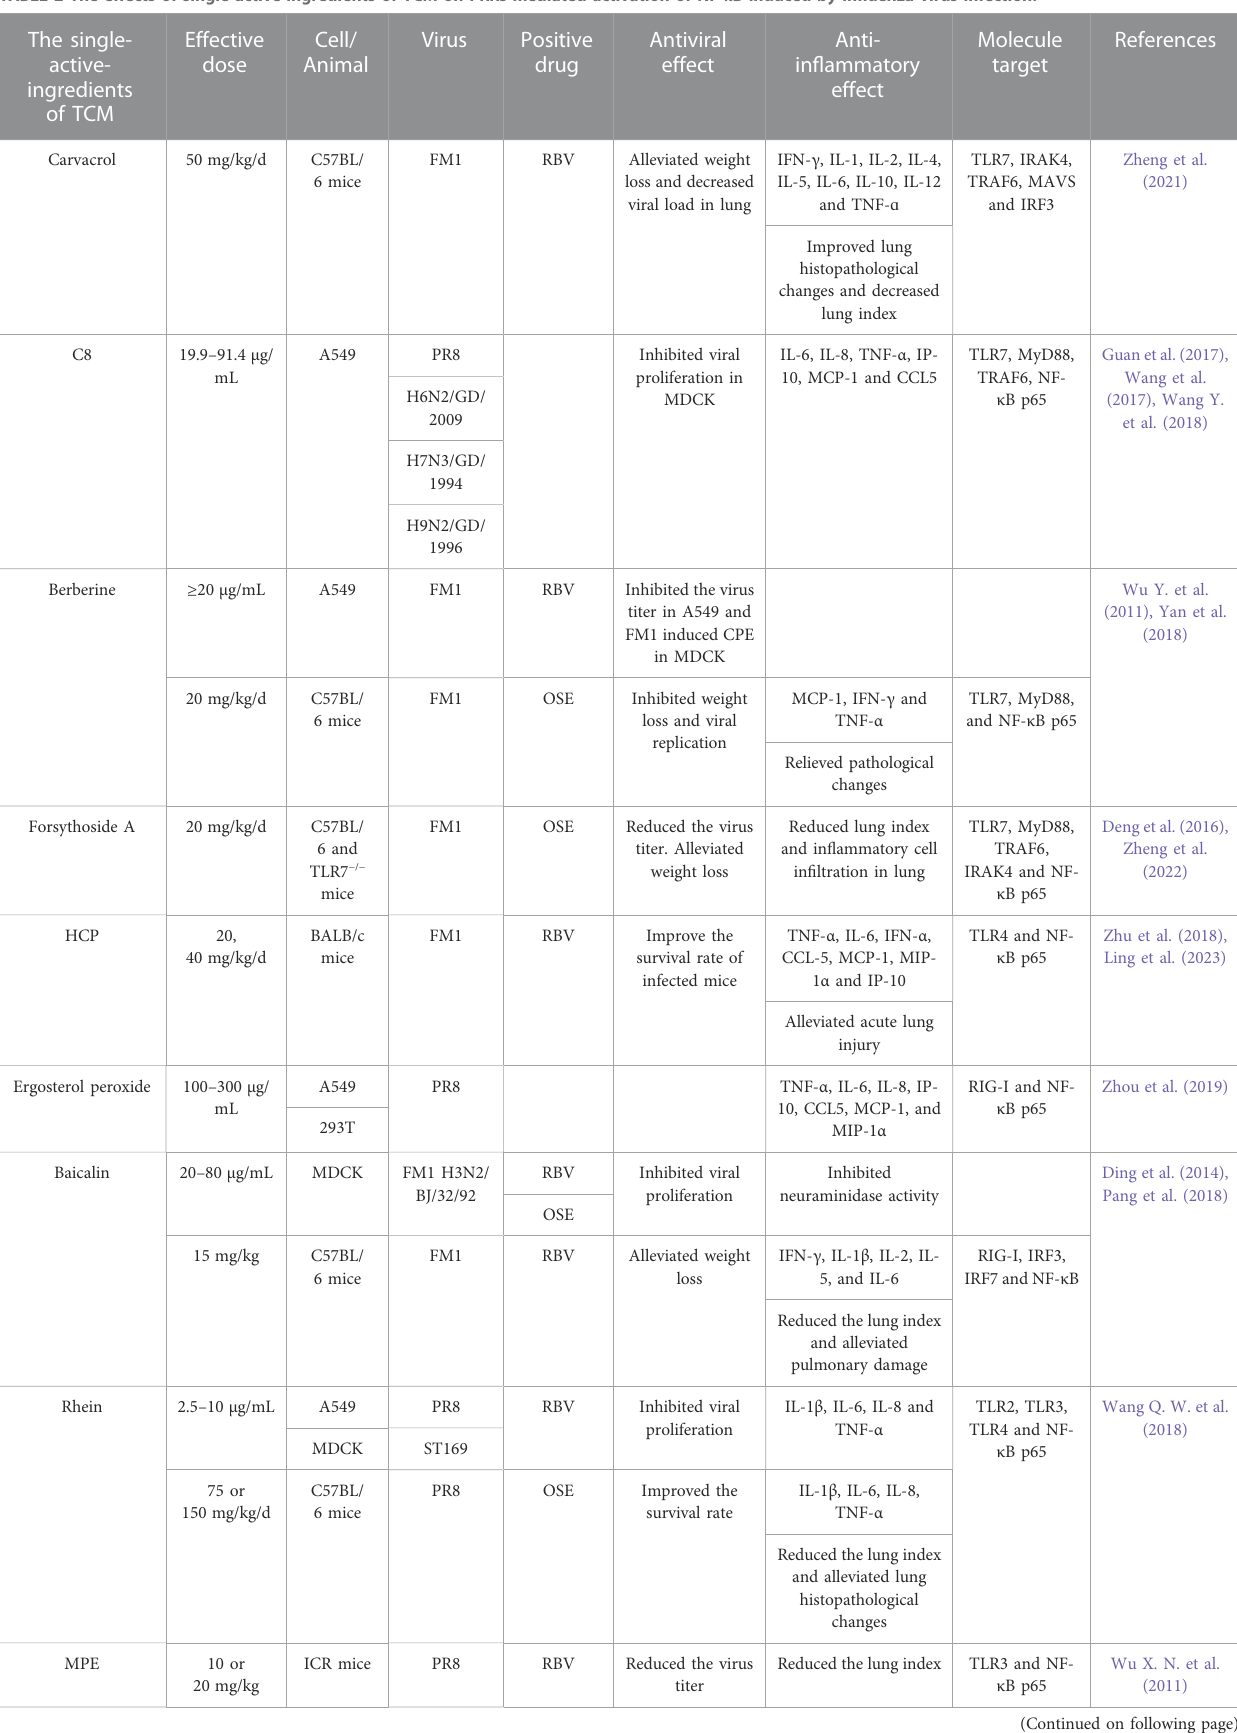
TABLE 2 The effects of single-active-ingredients of TCM on PRRs-mediated activation of NF- κ B induced by in fl uenza virus infection. The single-